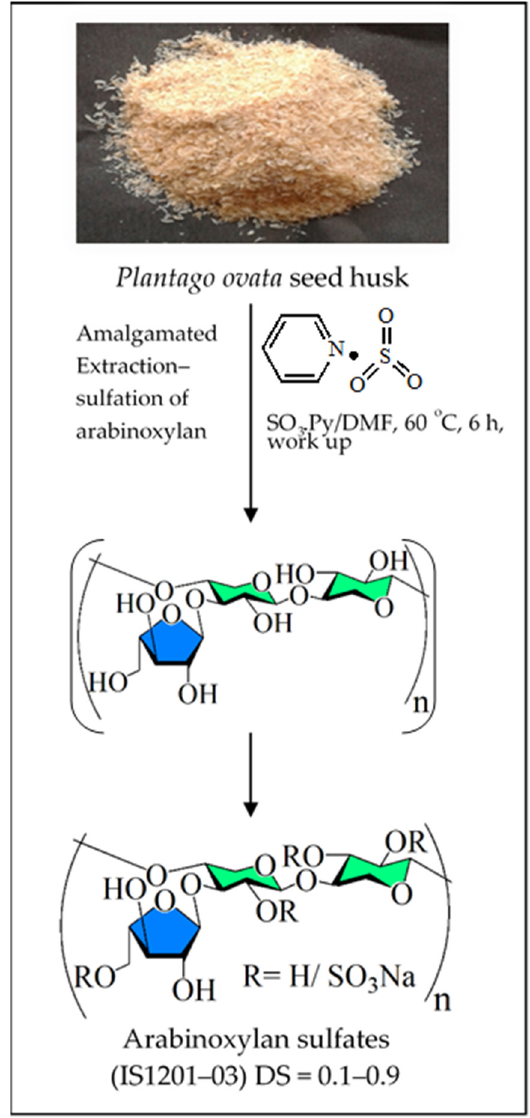
Figure 1. Schematic representation of the production of arabinoxylan sulfates from P. ovata seed husk using SO 3 .Pyr reagent in DMF at 60 °C [46]. Notably, drawings are not intended to be representative of the full sample composition.